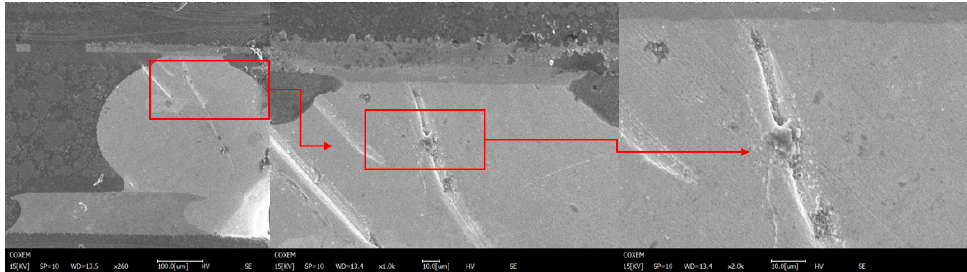
Figure 11. Diagonal cross-sectional 260×,1000× and 2000× SEM images of the solder joint which has large cracks after thermal shocks.